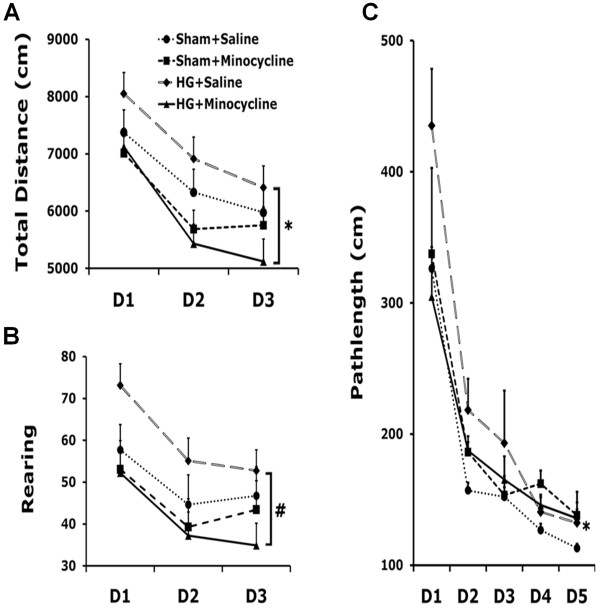
Minocycline reduces motor hyperactivity and cognitive impairment induced by hypoglycemia. Six weeks after induction of hypoglycemia, rats were subjected to a 3-day novel open field test followed by the Barnes maze test. Four groups of animals were divided for behavioral testing as follows: sham + Vehicle; sham + minocycline (MINO); hypoglycemia + Vehicle; and hypoglycemia + minocycline (MINO) groups. Minocycline reduced overall hyperactivity induced by hypoglycemia in both horizontal and vertical dimensions as shown in total path length (A) and rearing events (B). Minocycline also improved the performance of rats with hypoglycemia in the Barnes maze test over 5 days of training (C). *P < 0.05, #P < 0.01 comparing HG + Vehicle and HG + MINO groups.